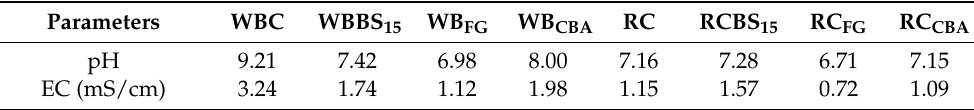
Table 7. Chemical properties of LWAs sintered at 1000 ◦ C compared to WBC (30% white clay–70% black clay) and RC samples containing clays only.